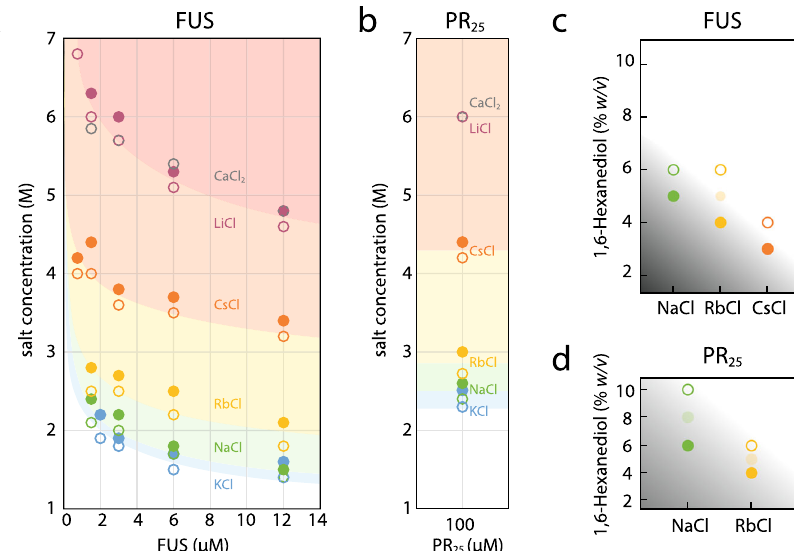
Fig. 5 Hofmeister effect in the high-salt phase separation behavior of FUS and PR 25 . a Phase diagram for FUS as a function of salt concentration of various salts of the Hofmeister series. Open circles indicate cases where phase separation did not occur, closed circles indicate where phase separation did occur. Each curve depicts the apparent phase boundary for the particular salt named next to it and is only meant as a guide for the eyes. Even at the saturation concentration of CaCl 2 (gray), the hydrophobic effect is weakened to the extent such that phase separation cannot occur, indicated by the presence of open circles and absence of closed ones in the phase diagram. b Phase behavior of PR 25 as a function of ionic strength of various salts. The trend is consistent with panel a . c Comparison of the amount of 1,6-hexanediol required to dissolve FUS condensates in solutions of various salts along with the Hofmeister series. In each solution, the fi nal salt concentration was 4 M, and the fi nal FUS concentration was 2 μ M. Partially shaded circles represent conditions where the number of condensates was visibly reduced, but the condensates were not fully dissolved. d Comparison of the amount of 1,6-hexanediol required to dissolve PR 25 as a function of salts along the Hofmeister series. The fi nal salt concentration at each point was 4 M and the PR 25 concentration was 100 μ series cations (Fig. 5a, b). The data show that the phase boundary shifts to higher salt concentrations in the order as given by the most agreed upon ordering of the series 75 (i.e., K + , Na + , Rb + , Cs + , Li + , Ca 2 + ); hence, condensate formation is disfavored with salts later in the series, as would be expected for a hydro- phobically driven process. Similarly, for both FUS and PR 25 , less